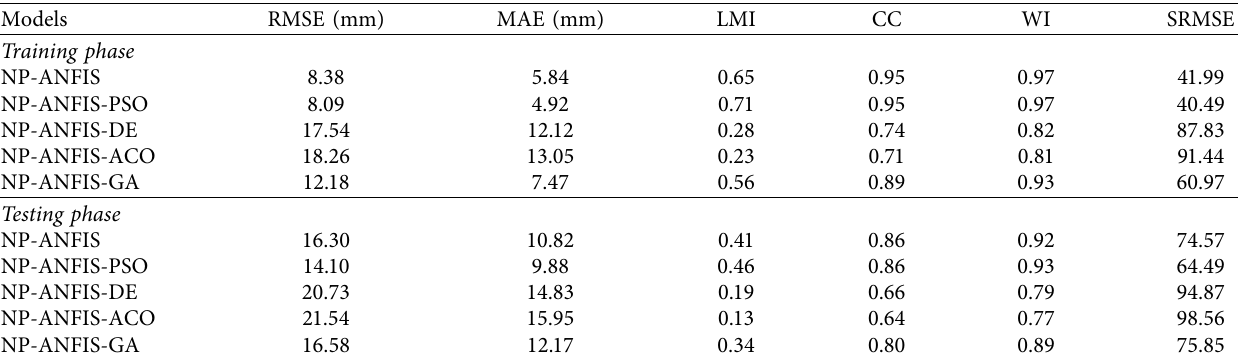
Table 2: The statistics of the employed parameters in training and testing phases. Table 3: The computed performance metrics over the training and testing phases and using preprocessed dataset scenario.